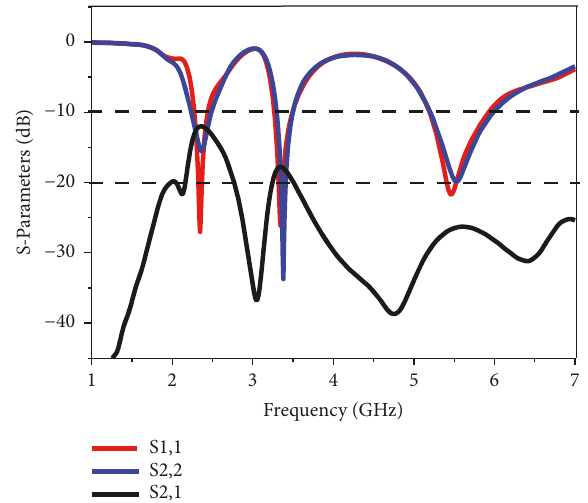
Figure 8: Simulated S parameters for MIMO antenna array of (case